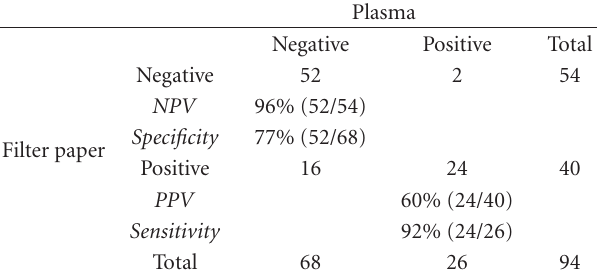
Table 1: Cross-tabulation results for the Filariasis CELISA com- paring paired plasma and filter paper samples. The gold standard was considered to be the result derived from the plasma sample (columns). ELISA specifications for a filter paper eluate was found to be a sensitivity of 92% (95%-CI = 75–99), specificity of 77% (95%-CI = 65–86), positive predictive value (PPV) of 60% (95%- CI = 43–75), and negative predictive value (NPV) of 96% (95%-CI = 87–100).